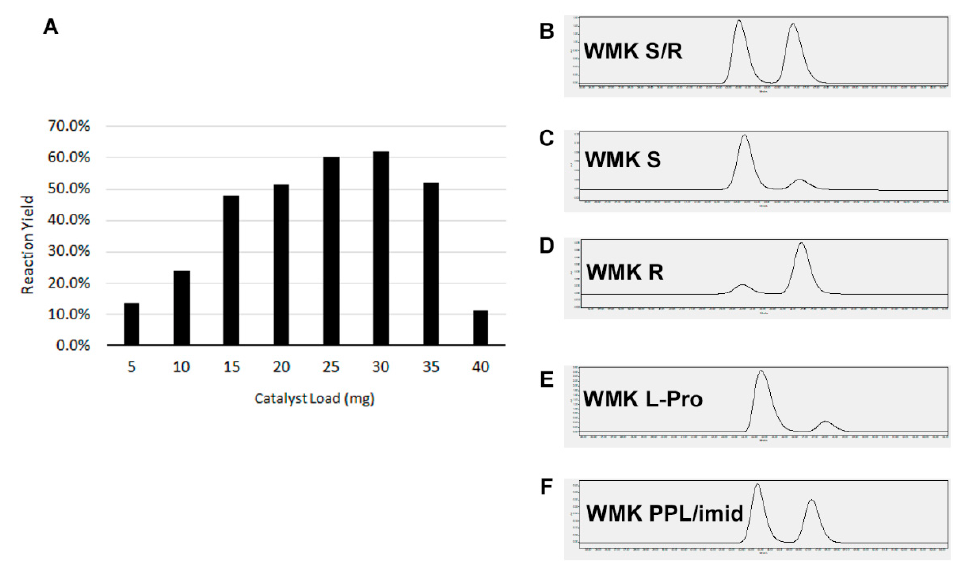
Figure 4. Effect of catalyst loading on reaction yield and determination of enantiomeric excess in L-Proline and PPL / imidazole catalyzed WMK reactions. ( A ) PPL / imidazole reactions in DMSO with varying amounts of PPL catalyst. Chiral HPLC chromatograms (Chiralcel OD-H column; mobile phase: isopropanol / heptane mixture (20 / 80, v / v ) containing 0.1% formic acid) are shown for: ( B ) racemic WMK standard; ( C ) S-WMK enriched standard; ( D ) R-WMK enriched standard; ( E ) purified L-proline catalyzed WMK product; and ( F ) purified PPL / imidazole catalyzed WMK product.